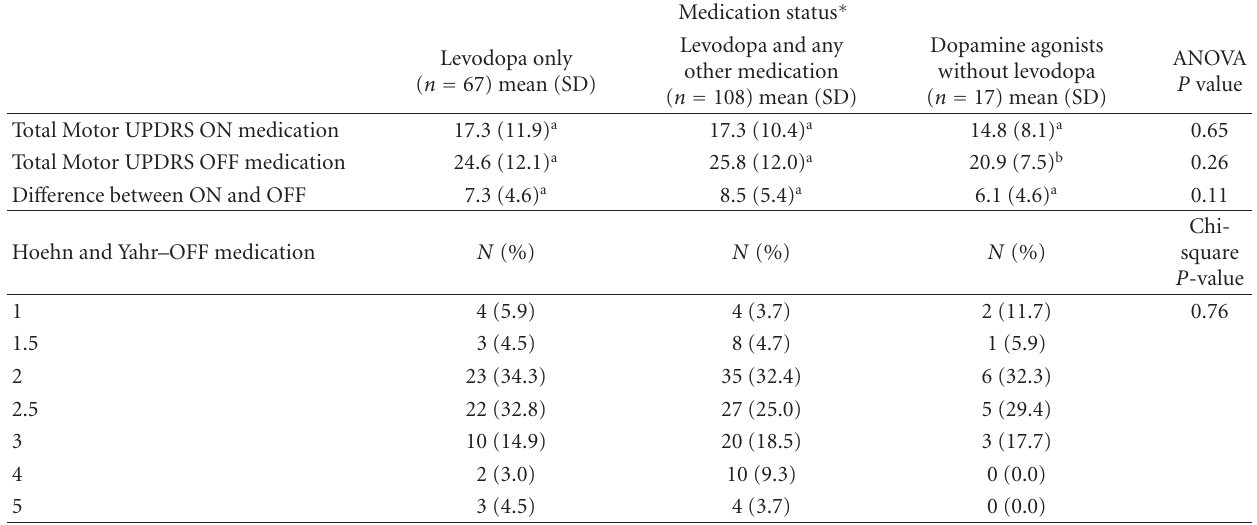
Table 3: Total Motor UPDRS ON and OFF medication by medication status ( n = 193).